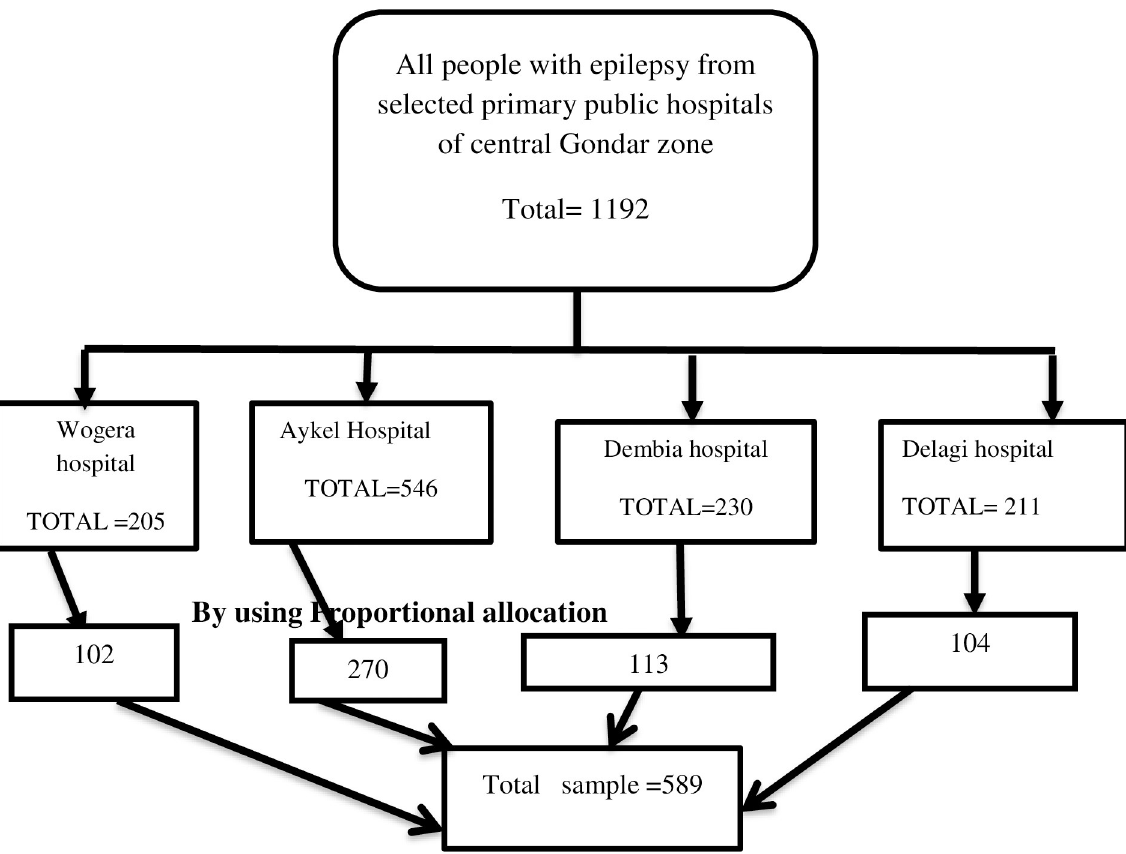
Fig 1. Schematic presentation of sampling procedure for assessment of magnitude and associated factors of depression and anxiety among people with epilepsy at out-patients treatment at central Gondar zone public hospitals, northern part Ethiopia.